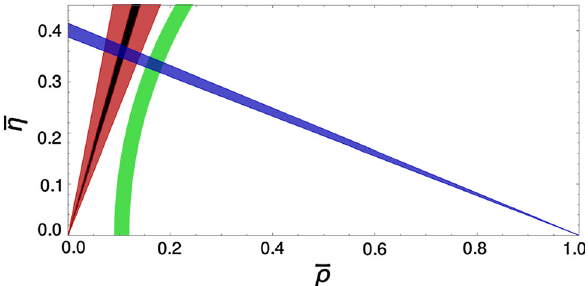
Fig. 2 ConstraintsontheUTfromtheangles γ (red)and β from S ψ K (blue), and R t from (cid:3) M d /(cid:3) M s